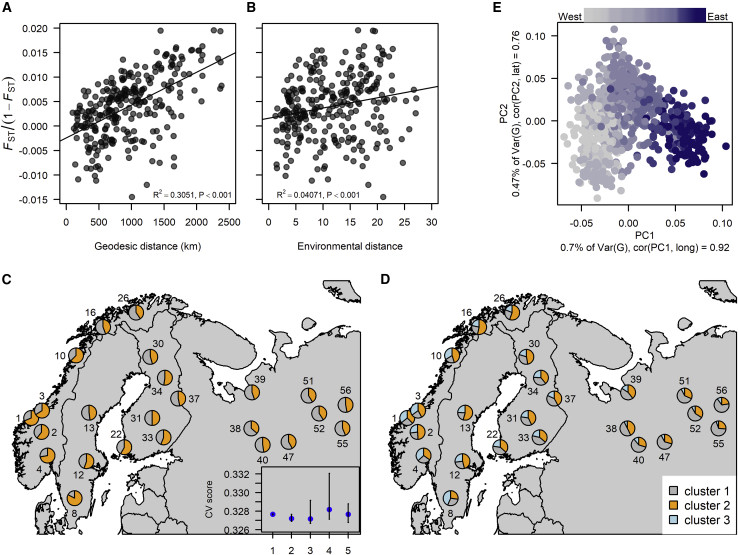
The spatial genetic structure across the genotyped populations using all SNPs.(A and B) The pairwise genetic differentiation across (A) geo-distance and (B) environment.(C and D) show the pie plots of genetic composition for K = 2 (C) and K = 3 (D) from TESS3. The blue points in the inlaid graph in (C) indicate the cross-validation score with the lowest root-mean-square error between the genotypic matrix and the fitted matrix among replications, for K = 1 to 5.(E) PCA of all genotyped seedlings, colored according to their longitudinal origin, with the darker color farther east. The two first PCA axes explained 1.17% of the genetic covariances among the seedlings. The PCA axes are also highly correlated with longitude (PC1) and latitude (PC2).